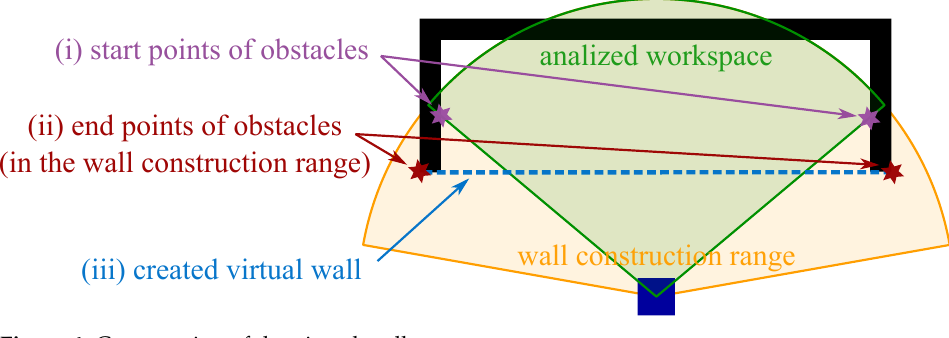
Figure 4. Construction of the virtual